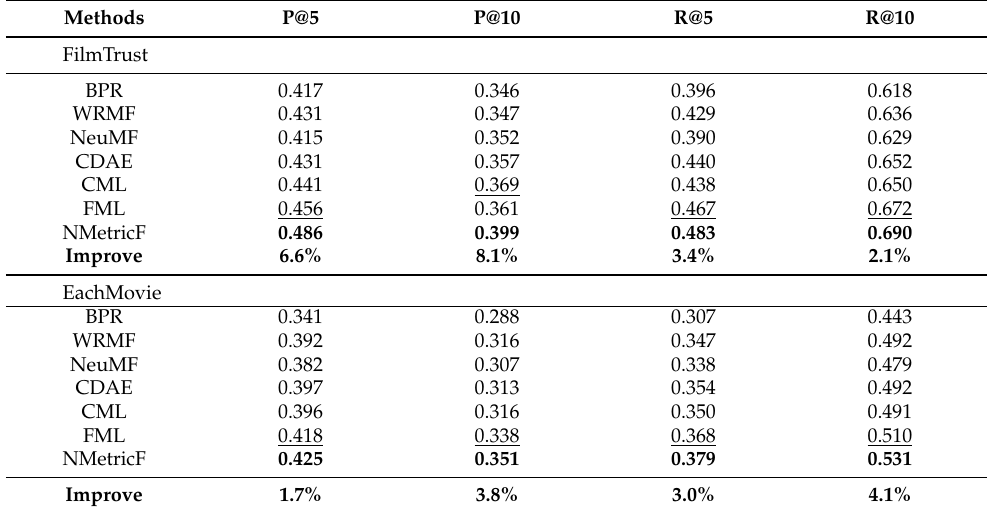
Table 4. Comparison between NMetricF and baselines in terms of RMSE. (Best performance is in boldface and second-best is